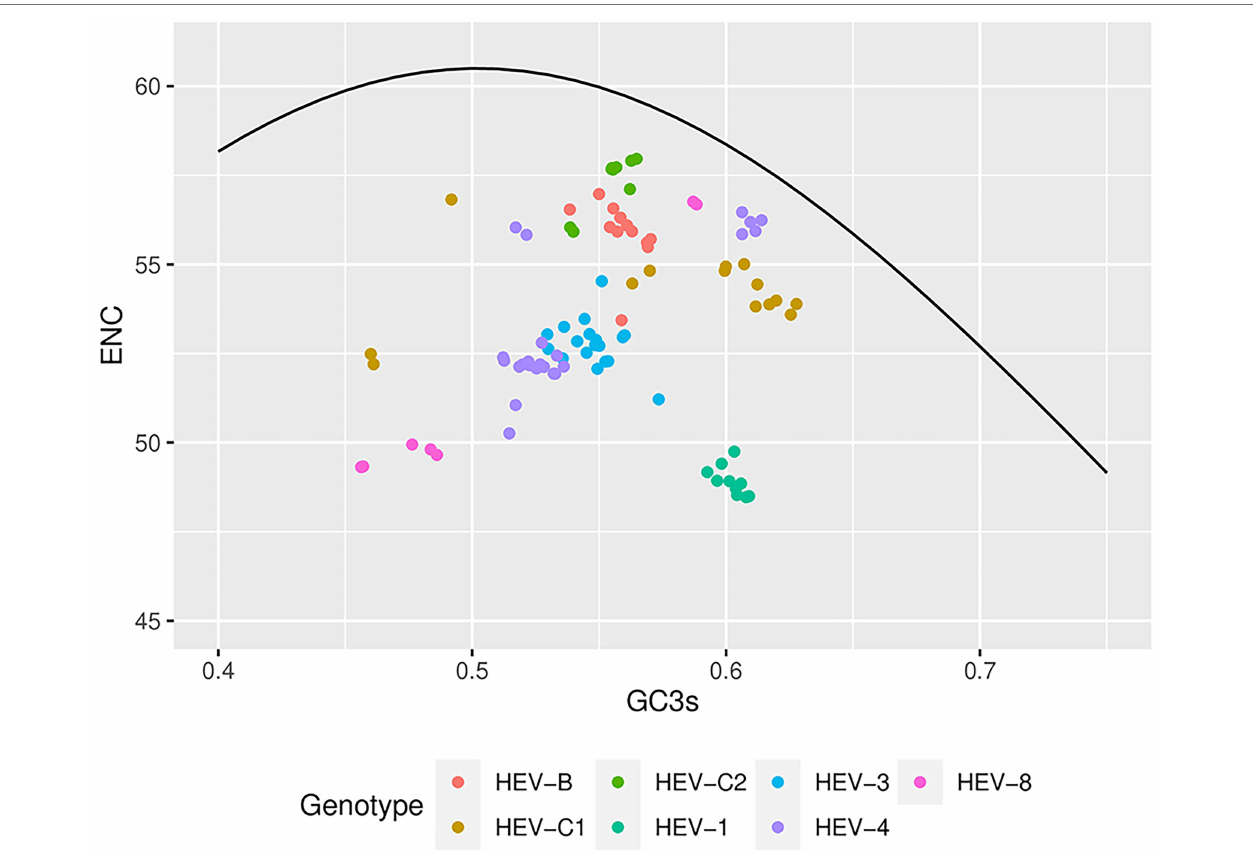
FIGURE 4 | Effective number of codons (ENCs)-plot analysis based on the HEV complete coding sequences. ENC values were plotted against GC3s of the genotypes. The black line represented the standard curve when the codon usage bias was determined by only the GC3s composition. Seven HEV genotypes were presented by colors.